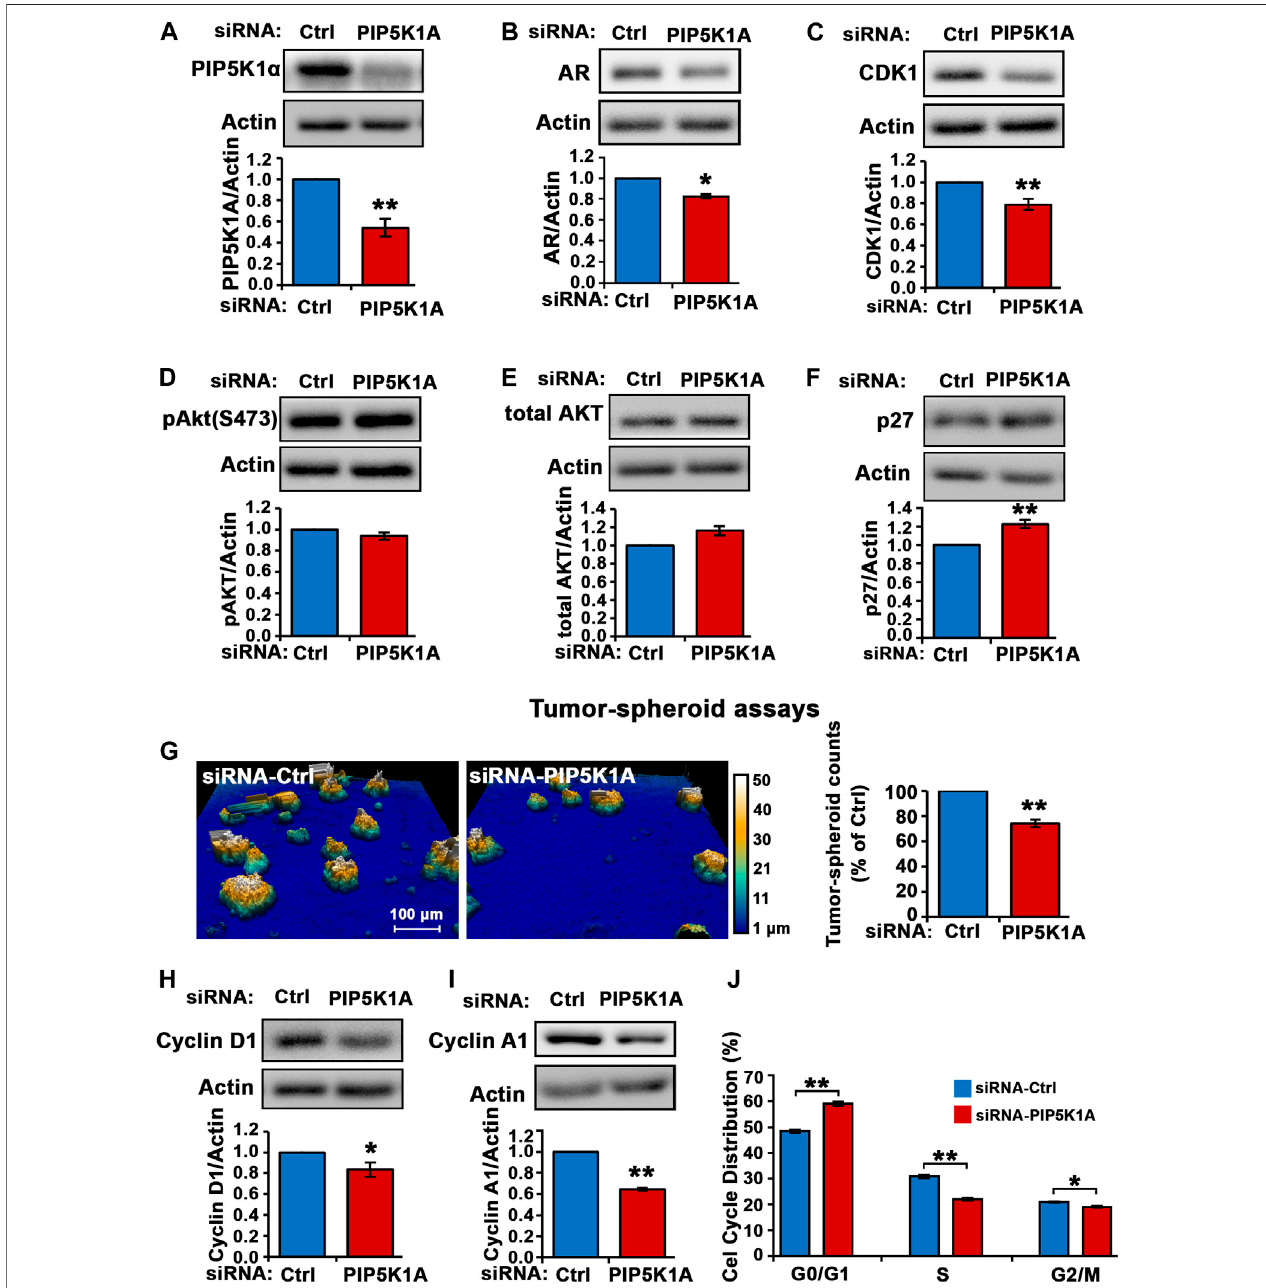
FIGURE 1 | The effect of PIP5K1 α inhibition on PIP5K1 α -associated pathways in C4-2 cells. (A) PIP5K1 α was silenced by transfecting C4-2 cells with control- siRNA (Ctrl-siRNA) or PIP5K1A-siRNA. Immunoblot analysis of PIP5K1 α expression in Ctrl-siRNA or PIP5K1A-siRNA transfected cells is shown. Quanti fi cations of the immunoblots for PIP5K1 α expression are shown. (B,C) The effect of knockdown of PIP5K1 α on AR and CDK1 was detected using immunoblot analysis. (D,E,F) Immunoblot analysis of pAKT, total AKT and P27 in Ctrl-siRNA or PIP5K1A-siRNA transfected cells is shown. (G) The digital Holomonitor M4 live-cell imaging system was applied to capture the tumor spheroids derived from C4-2 cells transfected with Ctrl-siRNA or PIP5K1A-siRNA. Representative images of tumor spheroids are shown in the left panel. The quanti fi cation of the counts of tumor spheroids from each group is shown in the right panel. (H,I) Immunoblot analysis shows the expression ofcyclinD1 and cyclinA1 in Ctrl-siRNA or PIP5K1A-siRNA transfected cells. (J) Cell cycle distributions of C4-2 cells transfected with CtrlsiRNA or PIP5K1A- siRNA were analysed by fl ow cytometry. Different cell cycle phases: G0/G1, S and G2/M are indicated. Data in this fi gure is presented as the average of three independent experiments (±SE). Student ’ s t -test was used in the analysis. * p < 0.05 or ** p < 0.01 are indicated.